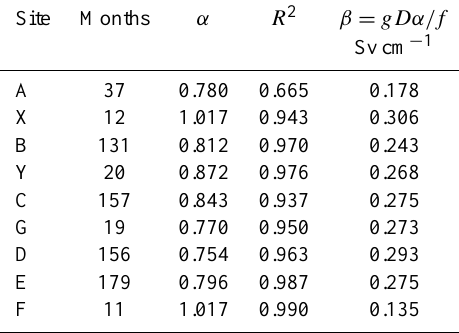
Table 6. Results of trend analyses for volume transport calculated Table 7. Relationship between average (surface to 5 ◦ C isotherm or from the ADCP observations and from Altimetry. The third column bottom) and surface along-channel velocity for the various ADCP shows the trend determined by linear regression of the residual from sites. The parameter α is determined by linear regression through a seasonal sinusoidal fit of volume transport on time and the fourth the origin and R 2 is the goodness of fit. The last column lists the column its 95% confidence interval assuming no serial correlation. empirical proportionality factor between transport and sea level dif- ference at each site according to Eq. Period Trend Conf. Int.